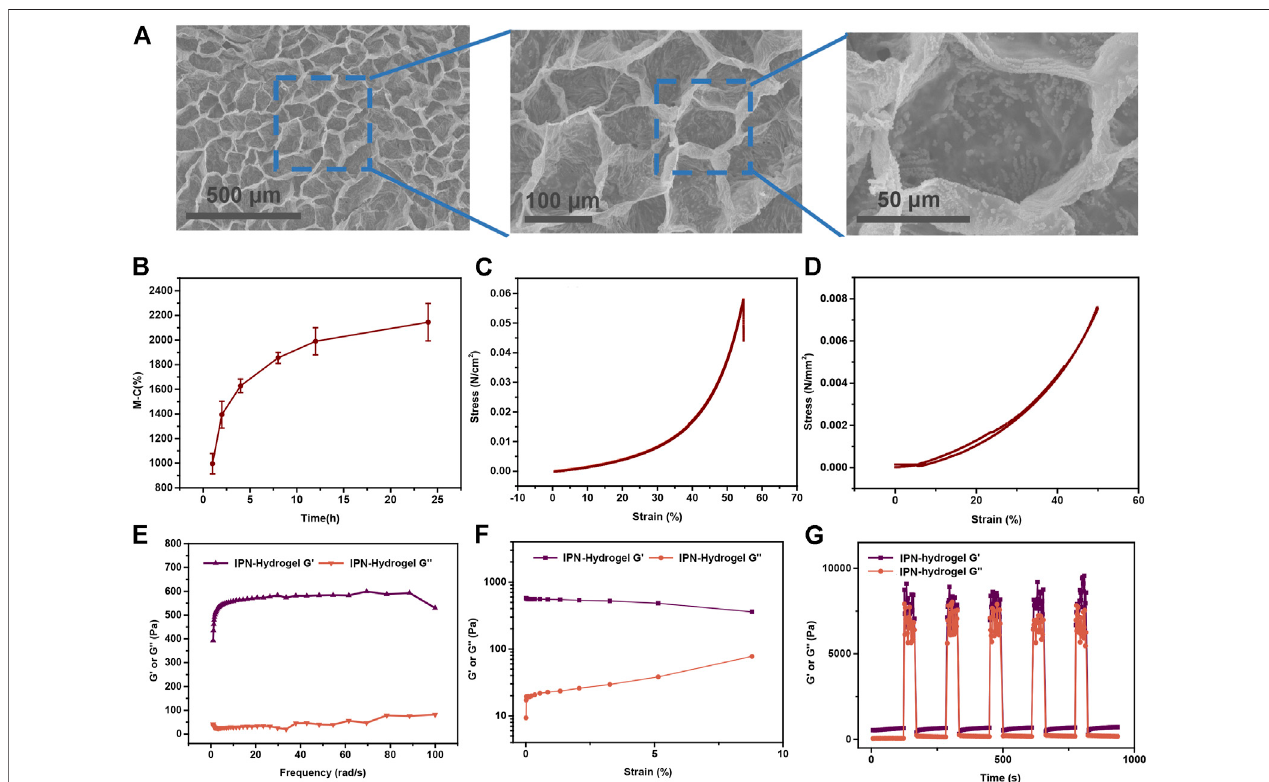
FIGURE5| Preparation and characterization ofPCSCs-hydrogels. (A) Surfacetopography and their localmagni fi cation oflyophilized PCSCs-hydrogels observed bySEM. (B) Swellingrateatdifferenttimefrom1to24 h. (C) Uniaxialstress – straincurvesundercompressionuntilcracking. (D) Uniaxialcompression – relaxationcurves. (E) G ′ andG ″ ofhydrogelsmeasuredinastrainsweepexperiment (from0.1to10%strain, 6.28 rad s-1)atroom temperature. (F) G ′ and G ″ ofthehydrogels measured in a frequency sweep experiment (from 0.1 to 60 rad s-1, 1% strain) at room temperature. (G) Hydrogels in a destroy – recovery experiment at room temperature. The frequency and strain were set to the frequency of 100 Hz and amplitude of 300% to destroy the coordination interactions and switched back to a frequency of 6.28 rad s-1 and amplitude of 0.1% to monitor recovery of the mechanical